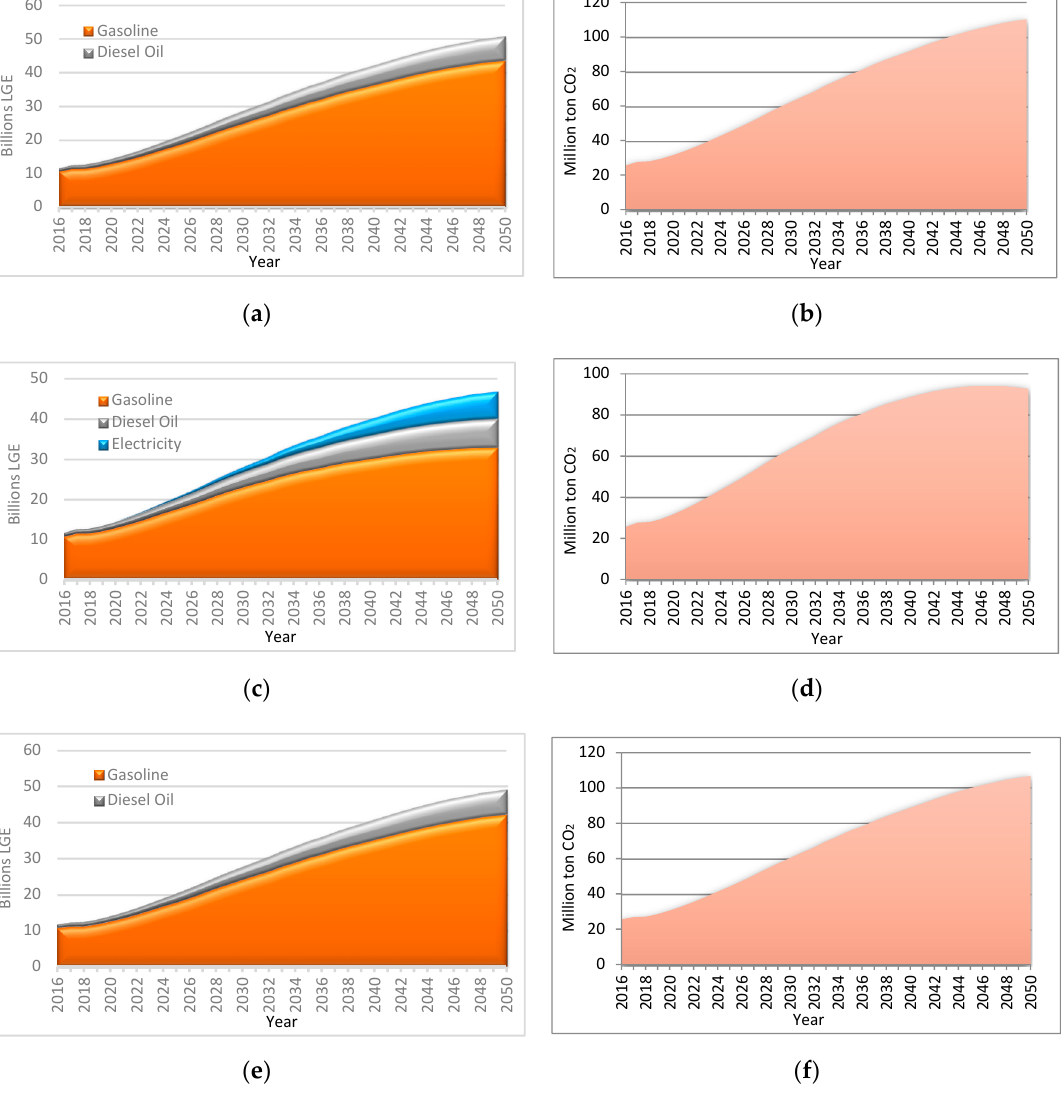
Figure 14. Results of energy demand and CO 2 emissions among scenarios. ( a ) Energy Demand (BAU Scenario); ( b ) CO 2 Emissions (BAU Scenario); ( c ) Energy Demand (Car Tech. Scenario); ( d ) CO 2 Emissions (Car Tech. Scenario); ( e ) Energy Demand (Fuel Tax Scenario); ( f ) CO 2 Emissions (Fuel Tax Scenario)